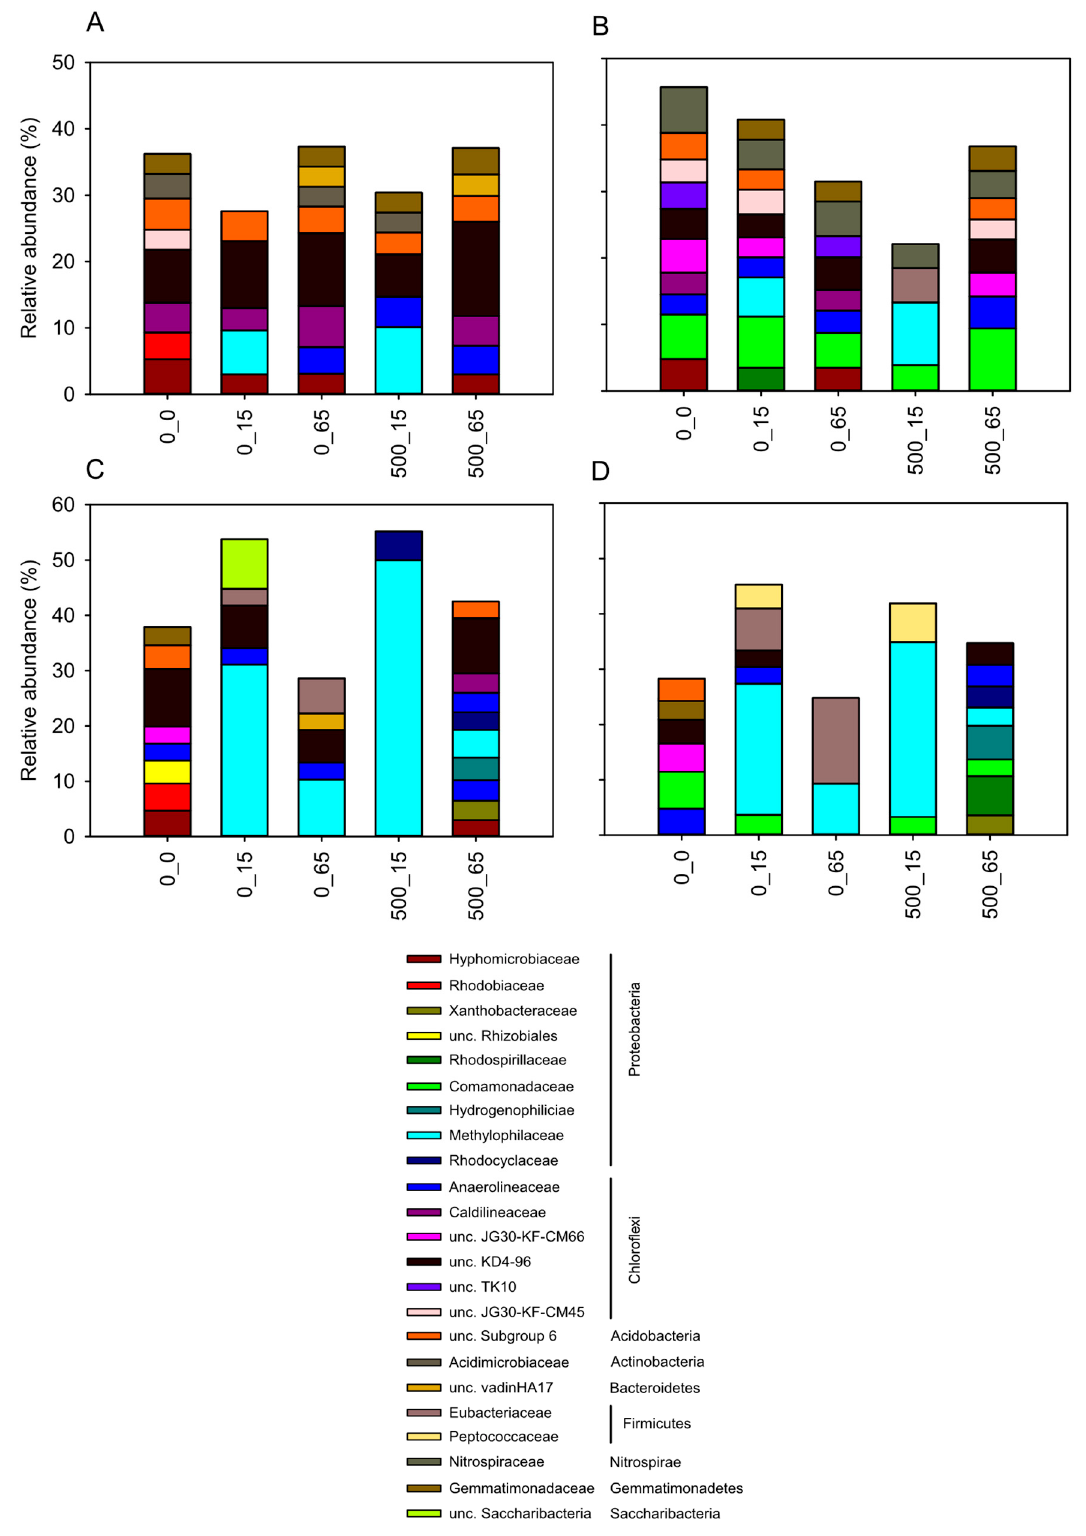
Figure 6. Mean relative abundance of major bacterial families ( > 3% relative abundance) on 16S rRNA gene ( A , C ) and 16S rRNA ( B , D ) level for surface ( A , B ) and subsurface ( C , D ) sediment samples. Sample code: 0, 500 indicate supplemental TrOC concentrations in µ g L − 1 . 0, 15, 65 represent sampling days.